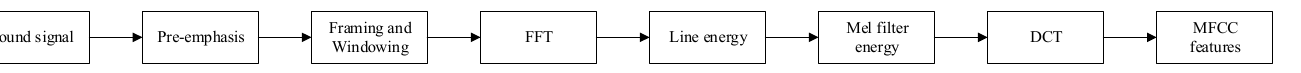
Figure 5. Block diagram of MFCC feature extraction.